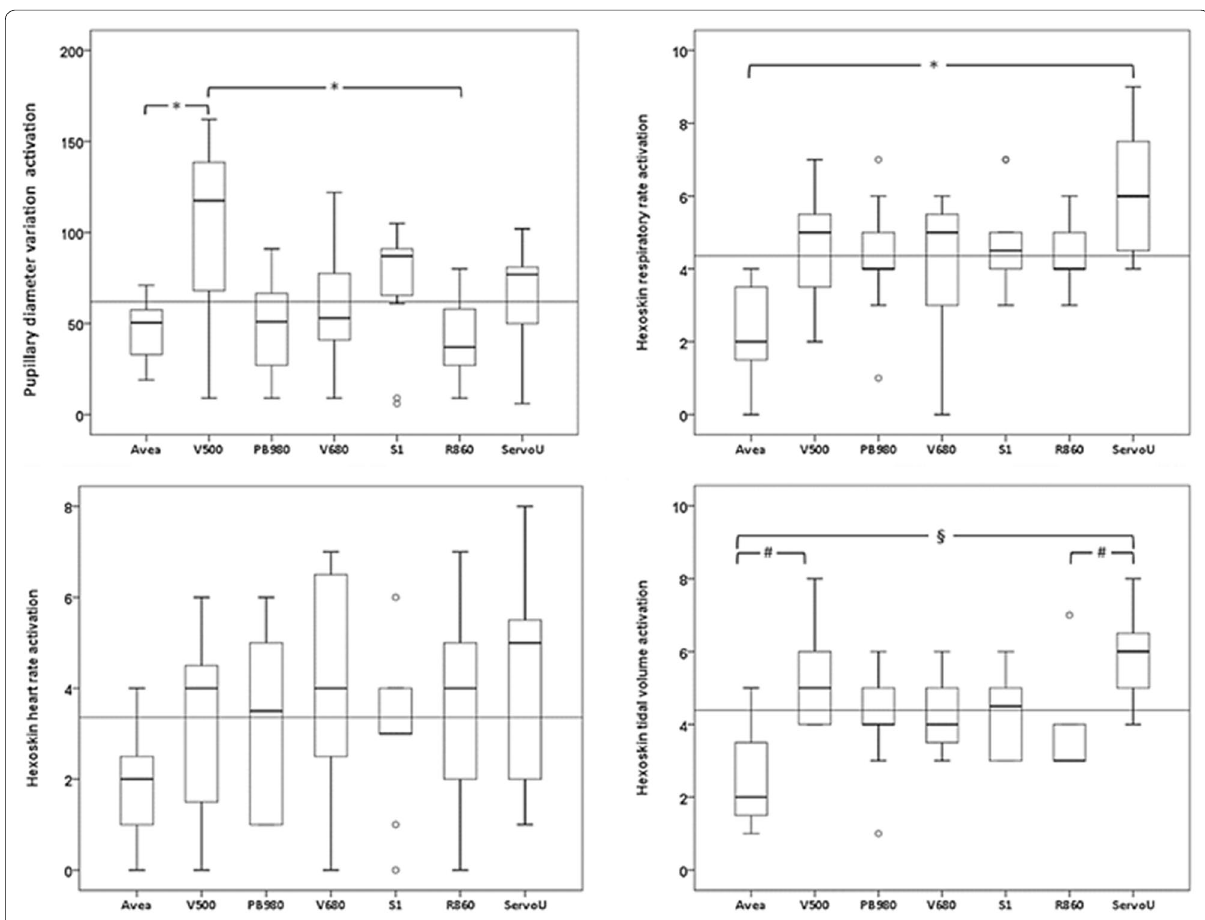
Fig. 7 Box plot of physiological measurements and eye-tracking activations. Several physiological parameters were recorded during objective tasks completion. These parameters were evaluated while detecting statistically different values, as compared to baseline. Each of these detections (‘ activations ’) is numerically integrated in order to evaluate the number of physiological variations in response to tasks. These activations are consid- ered to be adequate stress indicators. The number of activations is represented as median and interquartile. Dotted line is mean of activations for all ventilators, during all tests. For all parameters, our reference value depicted significantly fewer activations, thus validating our experimental concept. Significant papillary diameter, respiratory rate and tidal volume activations were observed for several devices (at least V500 and Servo-U). * p value <0.05; # p value <0.005; § p value